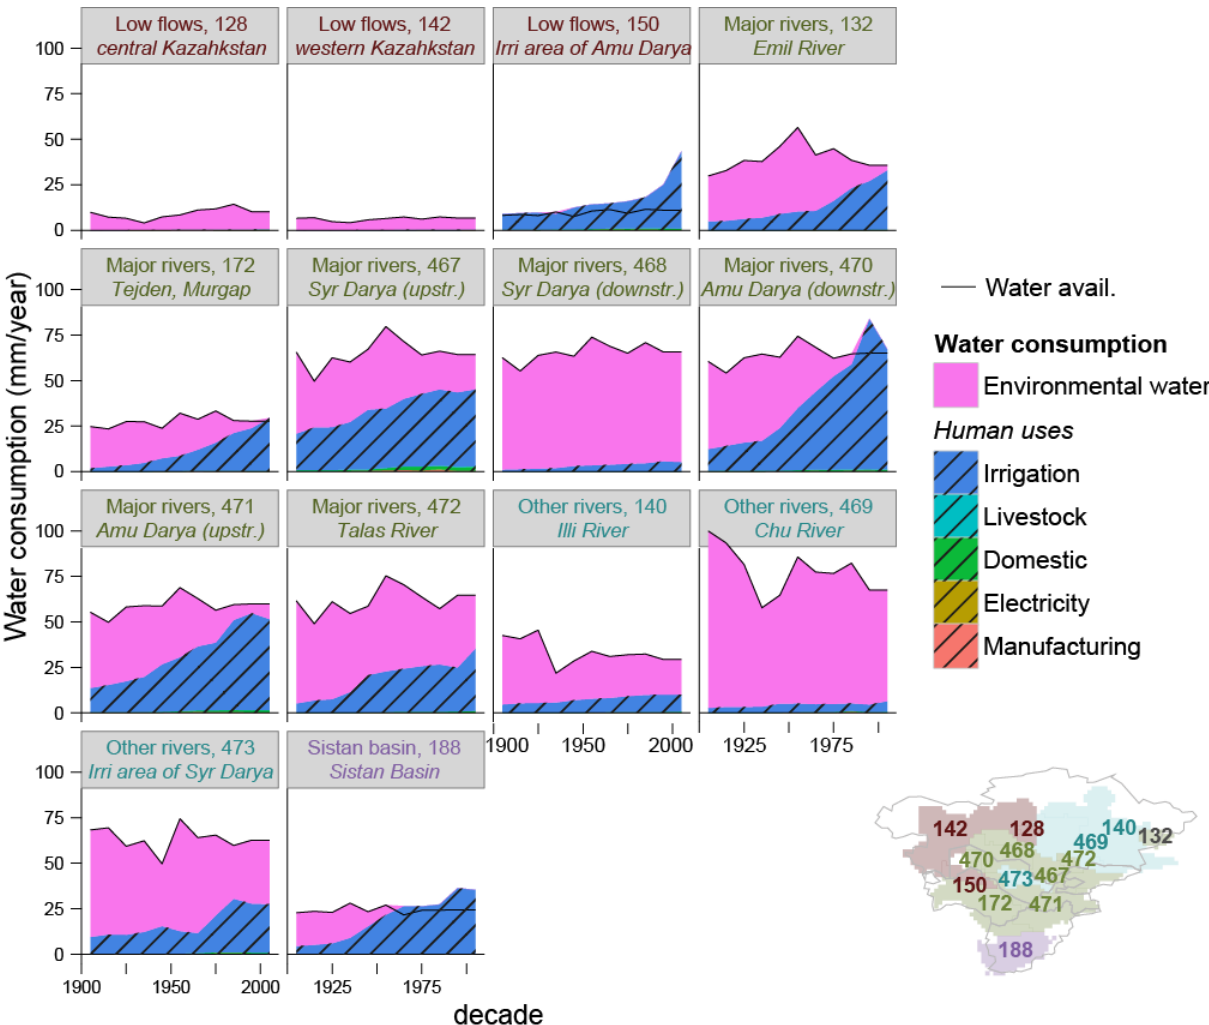
Figure 3. Total blue water use split by end-use of water ( i.e. , pathway in which it evaporates) for each food production unit (FPU) for 1905–2005, overlain with total water availability. Environmental water is defined here as the water that is available to aquatic ecosystems, calculated as the difference between availability and total human use